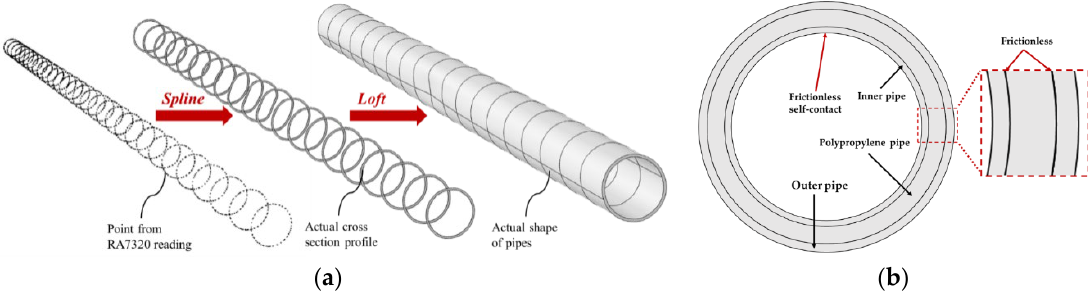
Figure 8. ( a ) Schematic diagram of scanning point modeling process for model validation; ( b ) schematic diagram of boundary conditions.